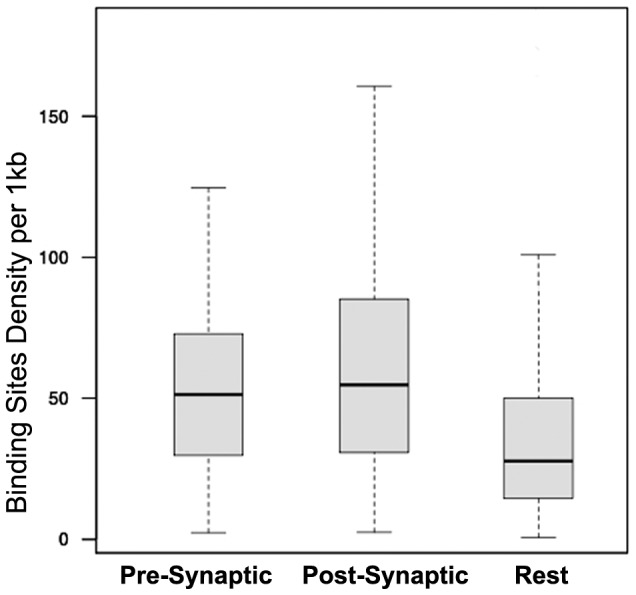
miRNA binding site density in synaptic 3′UTRs.Boxplots presenting binding site densities in the 3′UTR of presynaptic, postsynaptic and the rest of protein-coding transcripts.